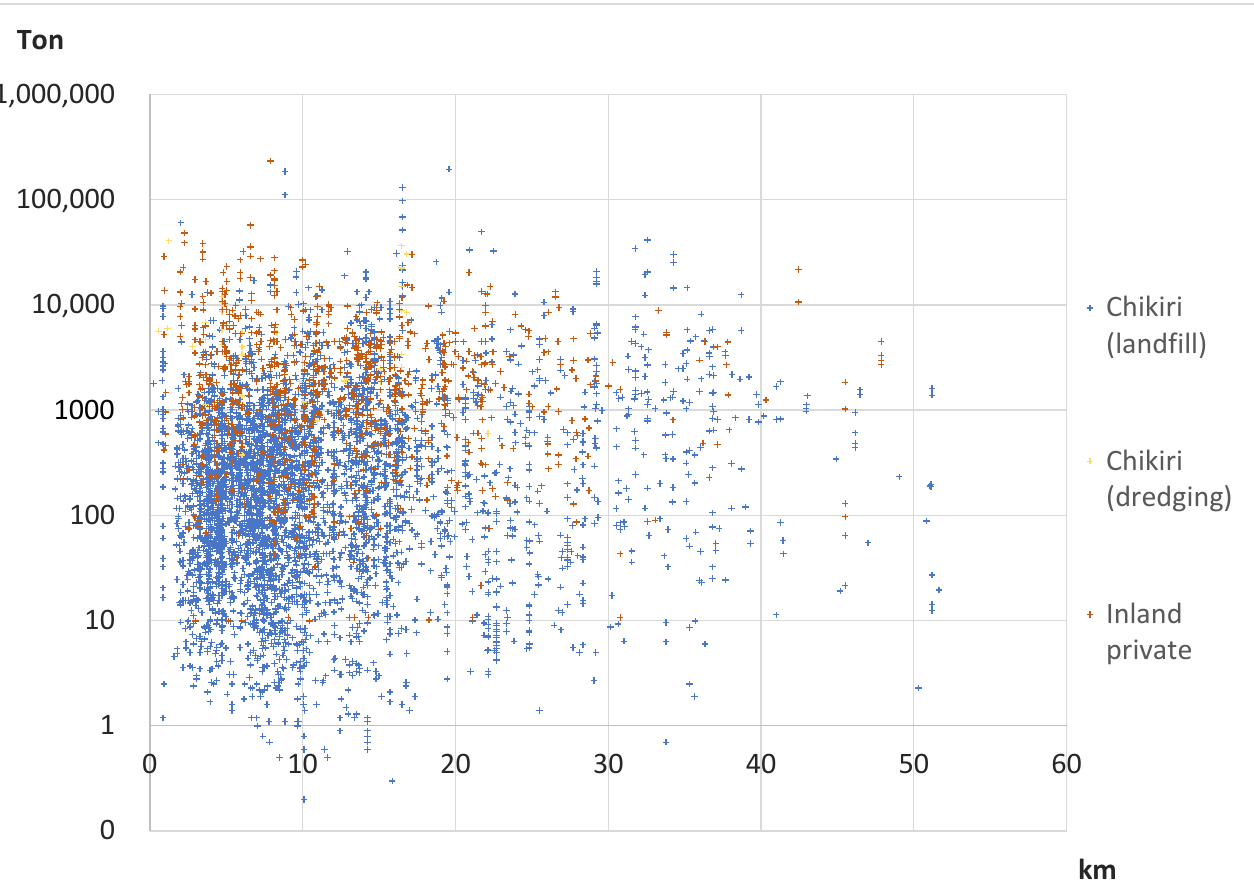
Figure 6. The weight–distance relationships of fill flows, showing the most common patterns of our mapped fill flow spatial characteristics.